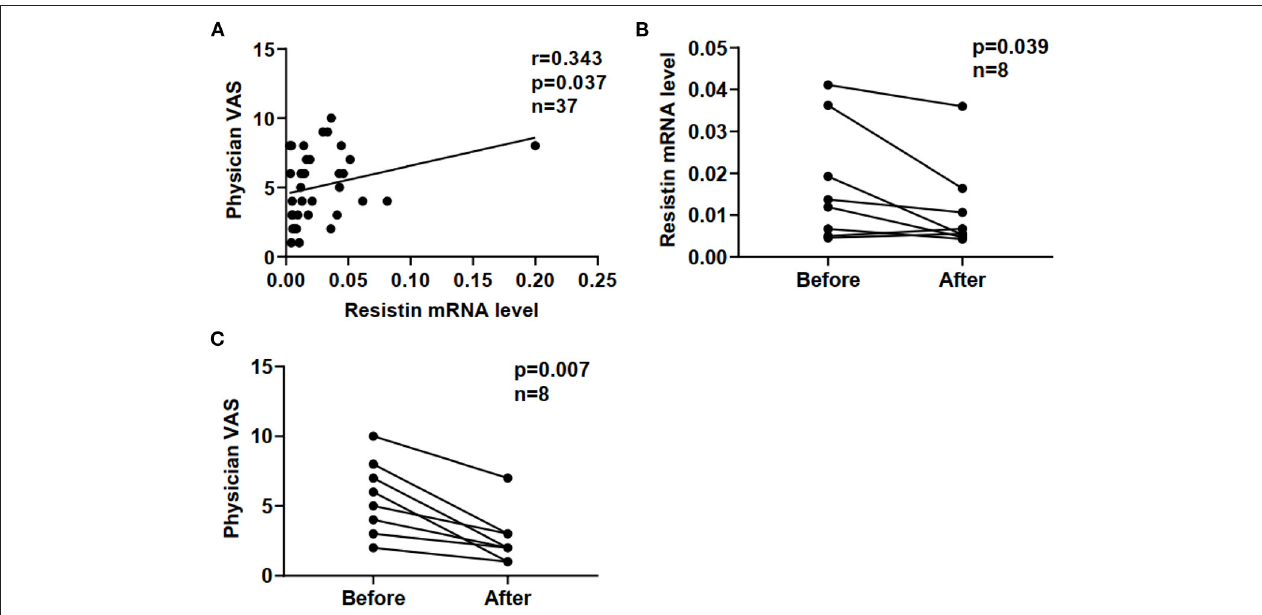
FIGURE 4 | Correlation between resistin mRNA levels and disease activities in DM-ILD. (A) Correlation between resistin mRNA levels and physician VAS scores. (B) Resistin mRNA levels before and after treatment. (C) Physician VAS scores before and after treatment. Paired analysis was assessed by Wilcoxon’s signed-rank test. DM, dermatomyositis; ILD, interstitial lung